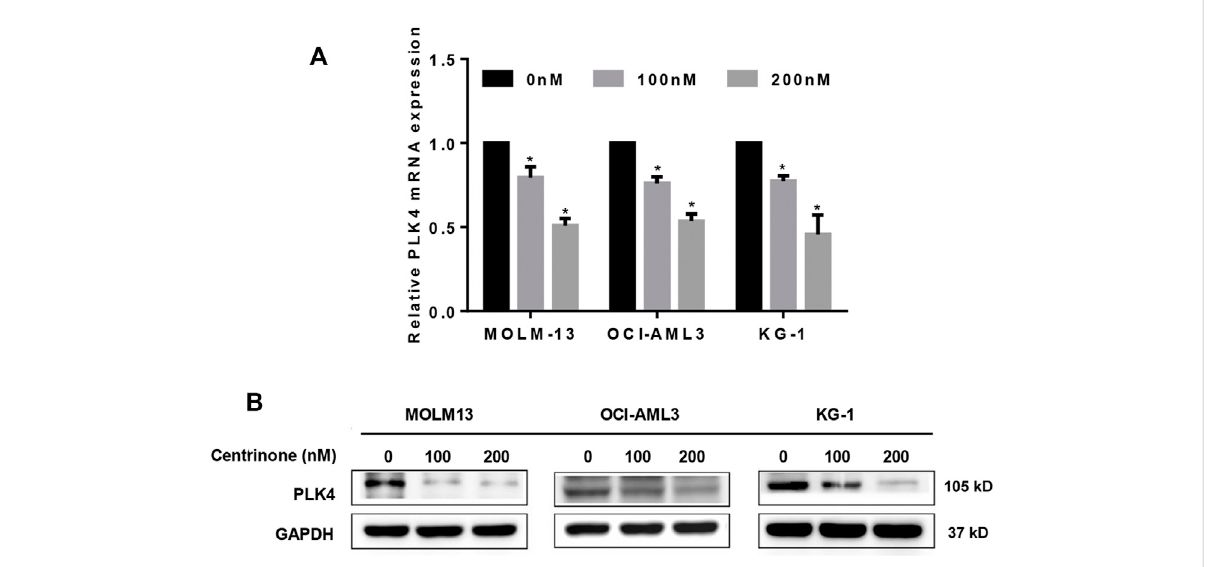
FIGURE 2 Centrinone inhibited the expression of PLK4. (A) The mRNA expression levels of PLK4 were detected by RT-PCR after AML cells treated with different concentrations of Centrinone for 72 h. Compared with the control group, * p < 0.05. (B) The expression of PLK4 were detected by Western blot in AML cells treated with diverse concentrations of Centrinone for 72 h and the expression of GAPDH was used as an internal control.